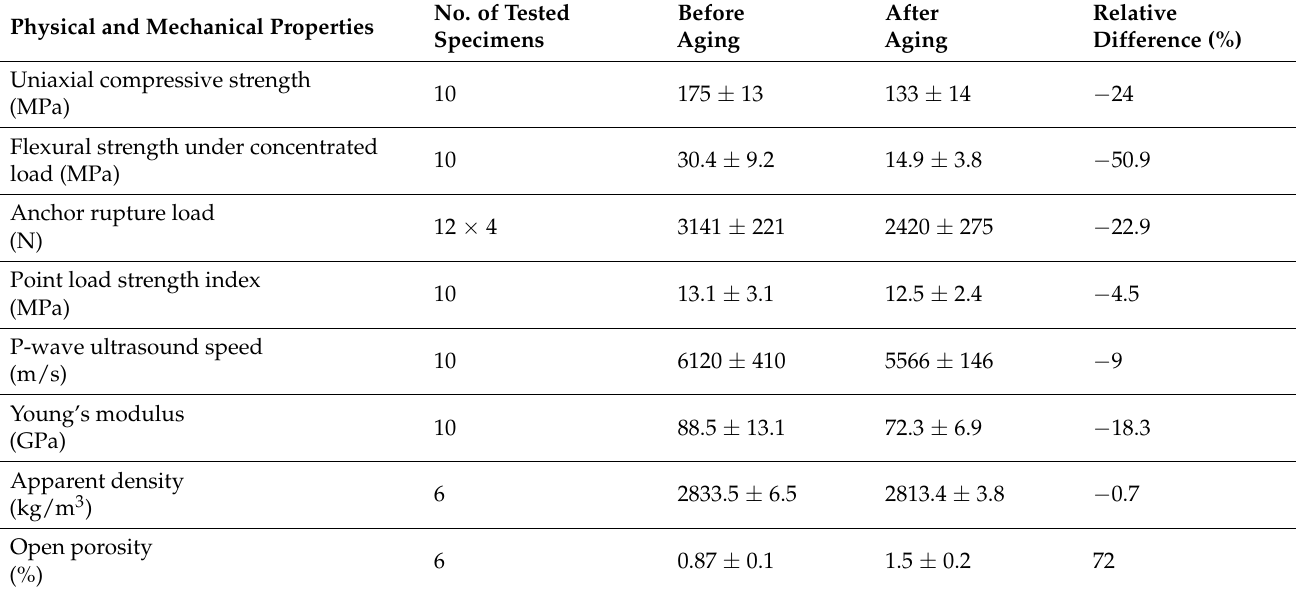
Table 3. Physical–mechanical properties of the slate selected to assess the impact of subarctic climatic conditions through seasonal cycles with a total length of four